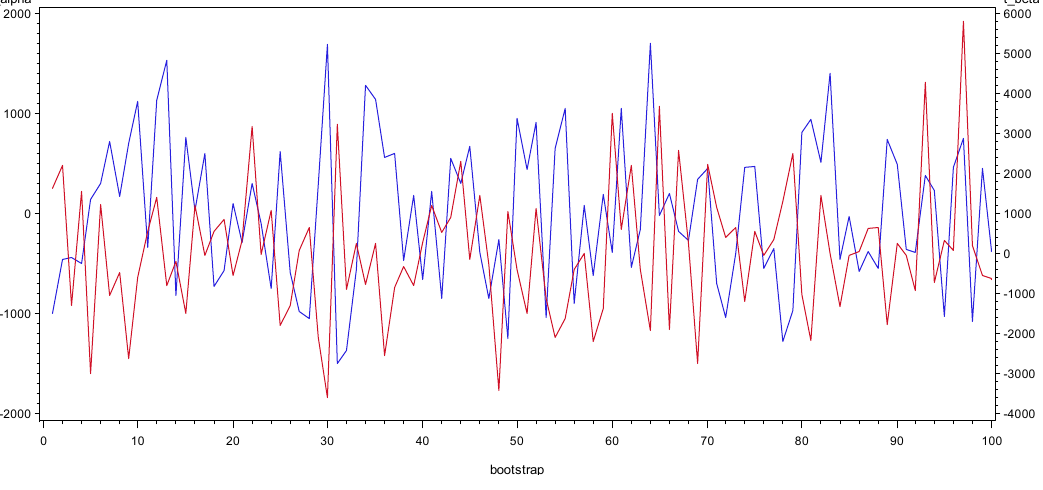
(cid:3550) (in blue). (cid:3081) (cid:3269) (cid:3554) (in (cid:98) β T